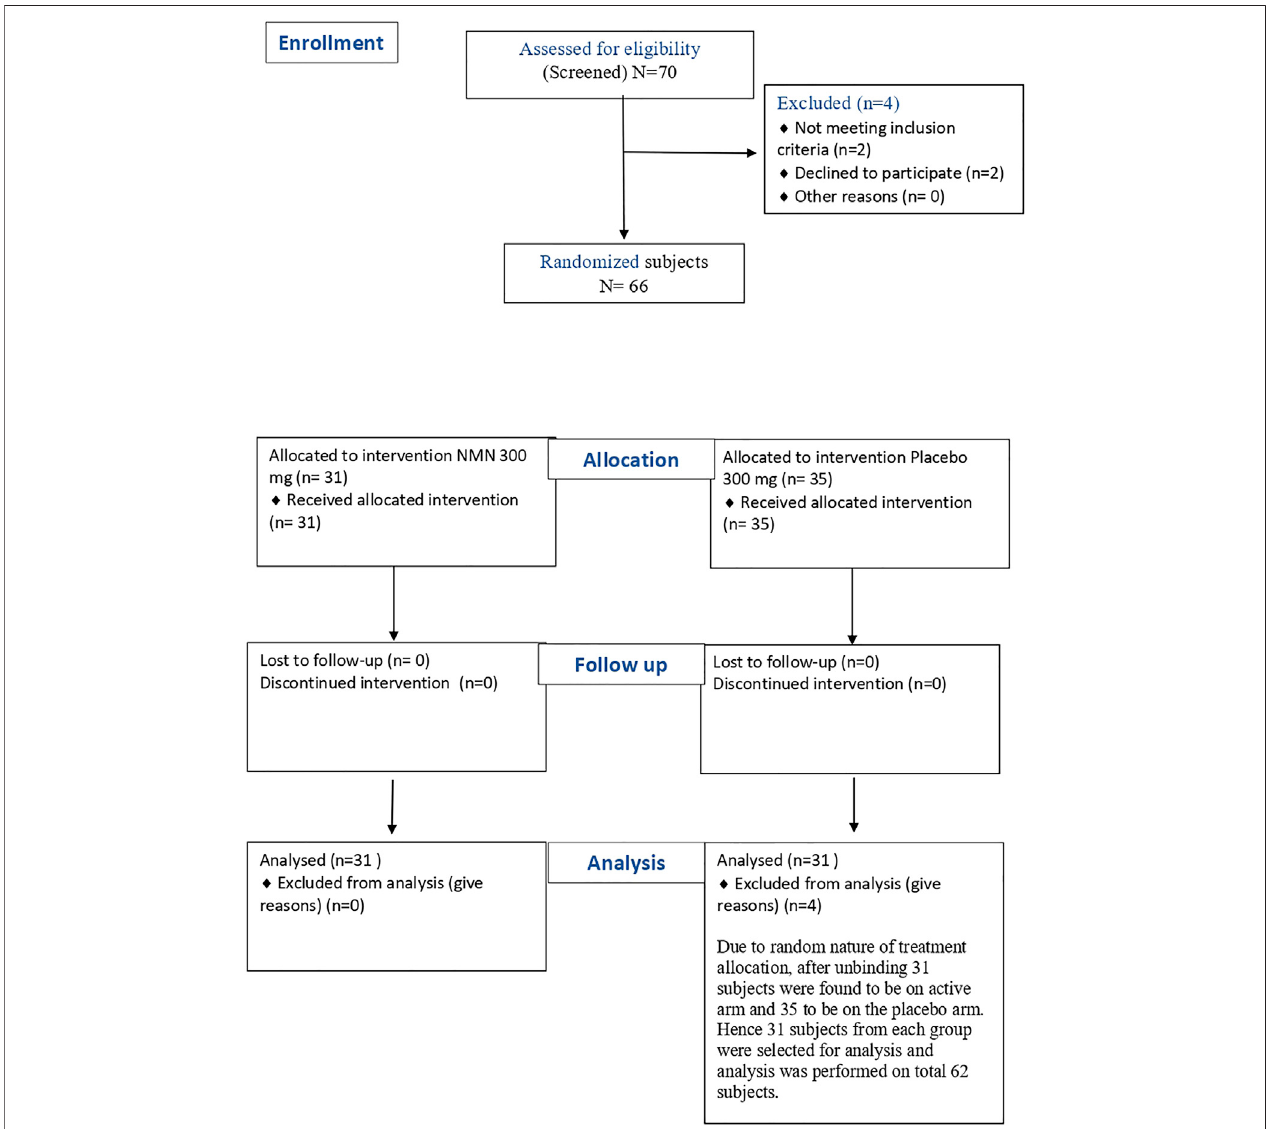
FIGURE 1 | Flow diagram for subject